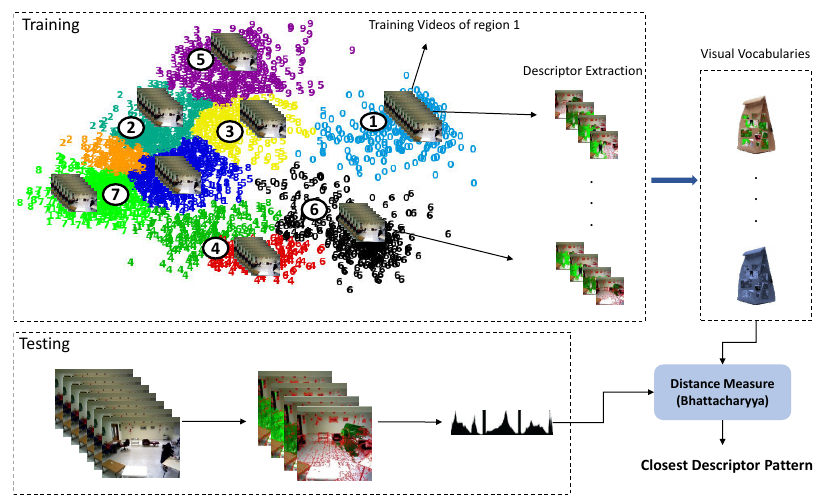
Figure 6. The process of learning visual codebook for each activity model and matching the given activity’s features with the most similar dictionary: Training and Testing